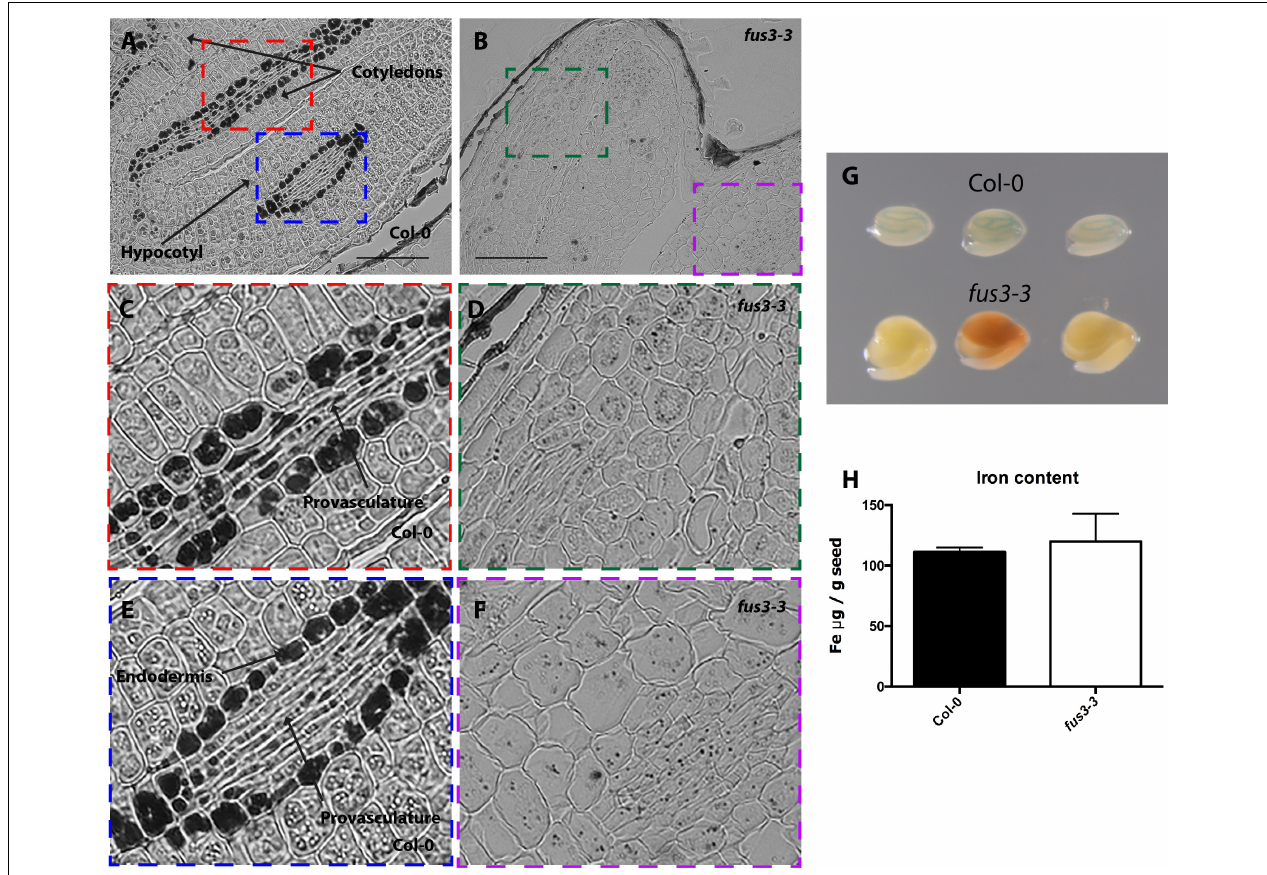
FIGURE 3 | Iron distribution and accumulation in fus3-3 mutants. Histological section of dry seed of Arabidopsis thaliana Col-0 (A,C,E) and fus3-3 (B,D,F) stained with Perls/DAB. (C,D) Cotyledons and (E,F) hypocotyl zoomed zones highlighted in colors in A and B. Bars = 100 µ m. (G) Perls staining in whole embryo, in the top row three Col-0 embryos, in the bottom row three fus3-3 . (H) Iron content in dry seed of Col-0 and fus3-3 . Four samples were analyzed for each